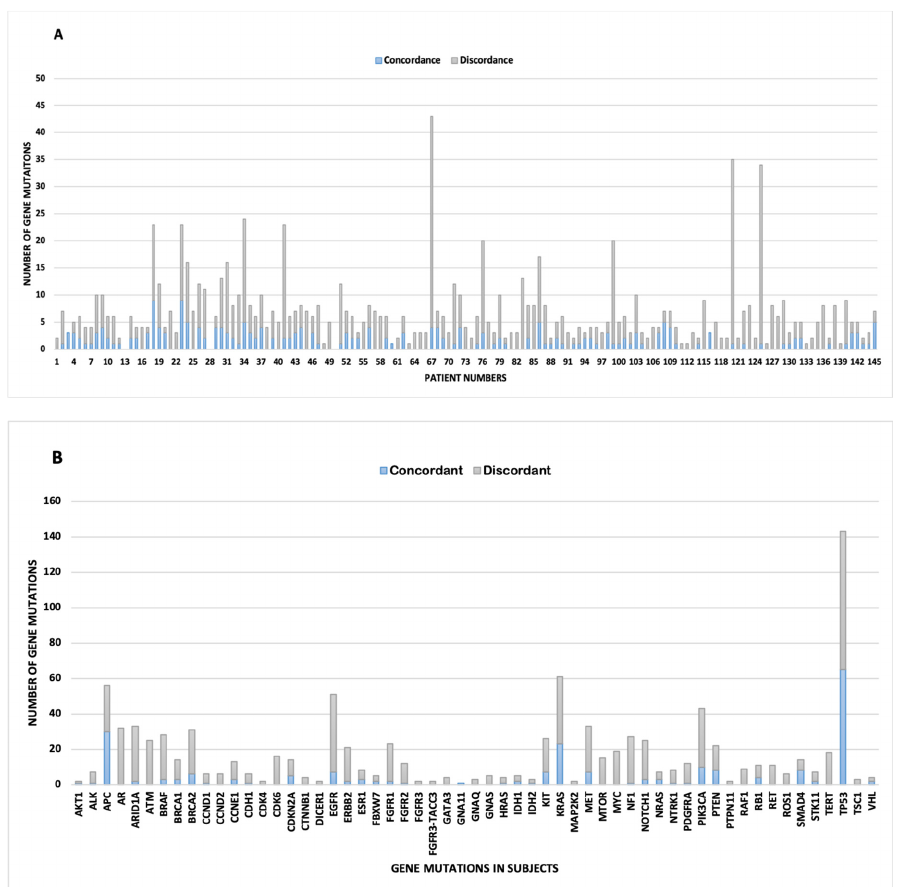
Figure 3. Concordance (blue) and discordance (gray) between gene mutations detected by tissue-based DNA (Caris) and plasma cell-free DNA (Guardant360) next generation sequencing. ( A ) Quantity of gene mutations stack-plotted per de-identified patient number. Discordance shows intra-patient genetic heterogeneity. ( B ) Quantity of gene alterations stack-plotted per mutated genes demonstrates driver and passenger gene mutations that contribute to intra-tumor heterogeneity. Gene mutations that displayed zero concordance and one discordant gene mutation were removed for clarity, and include ARID2, ATRX, DDR2, ERBB3, HNF1A, JAK2, MAP2K1, MLH1, and